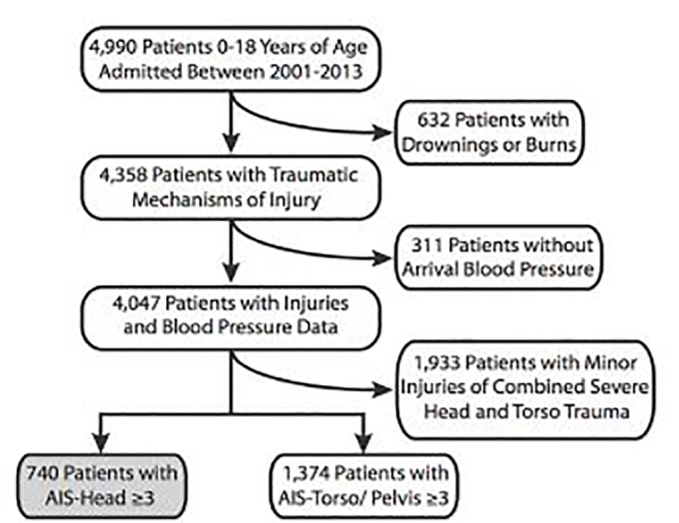
Study population of pediatric patients with traumatic brain injury.AIS, Abbreviated Injury Severity.